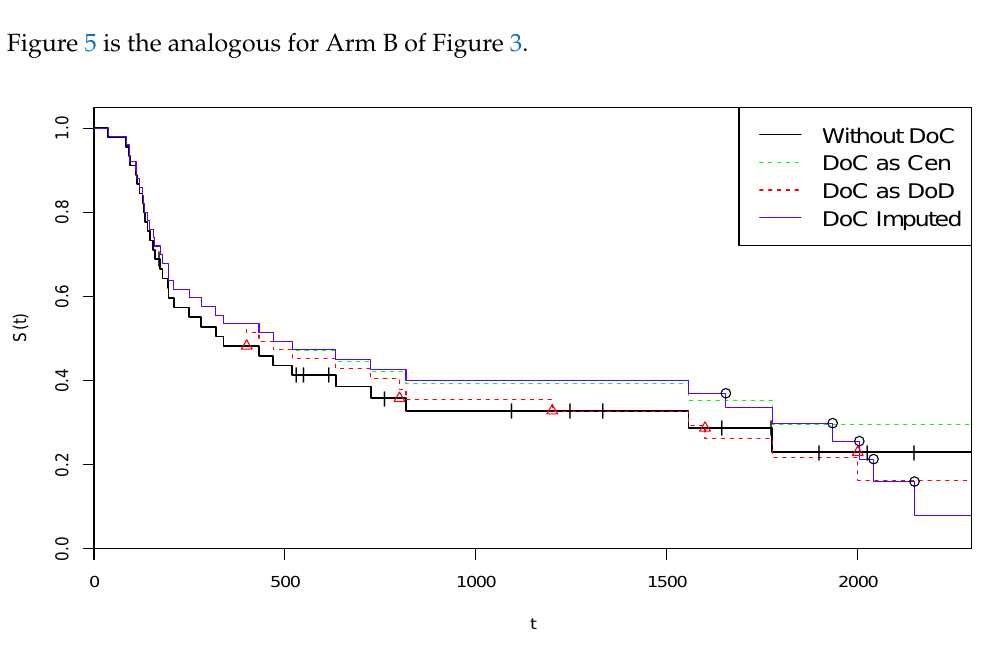
Figure 4. Kaplan–Meier curves for alternative treatments of COVID-19 deaths—Arm B.